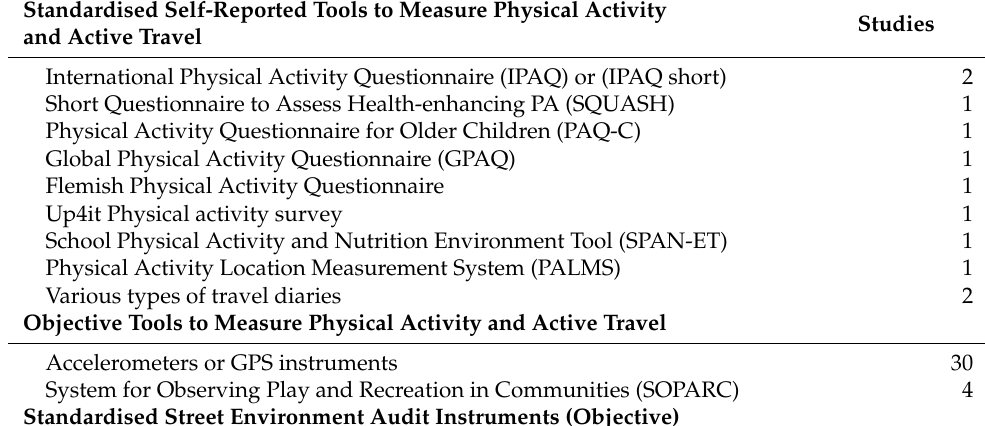
Table 2. Standardised tools to measure physical activity and active travel and street environments. Standardised Self-Reported Tools to Measure Physical Activity and Active